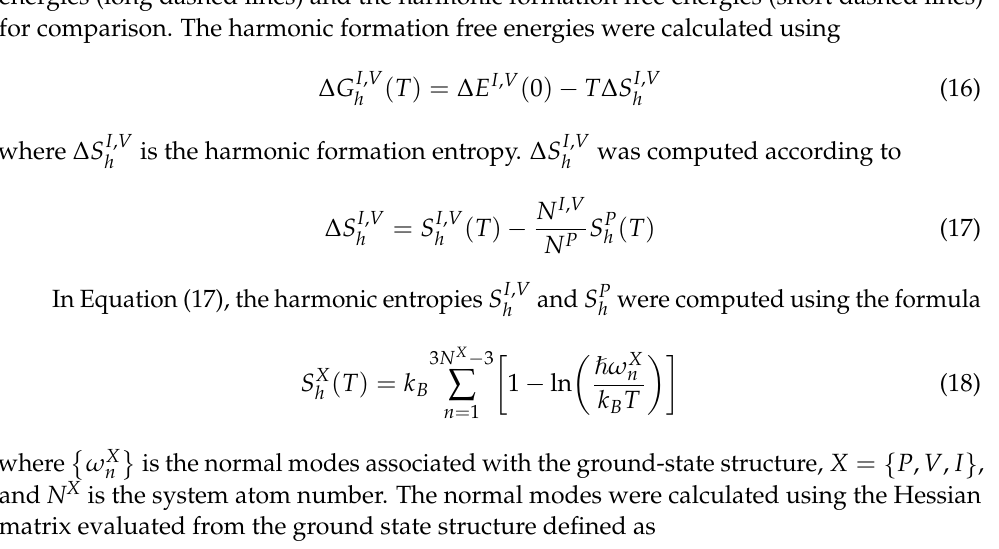
λ for ( a ) self-interstitial and ( b ) vacancy. Red for SW and